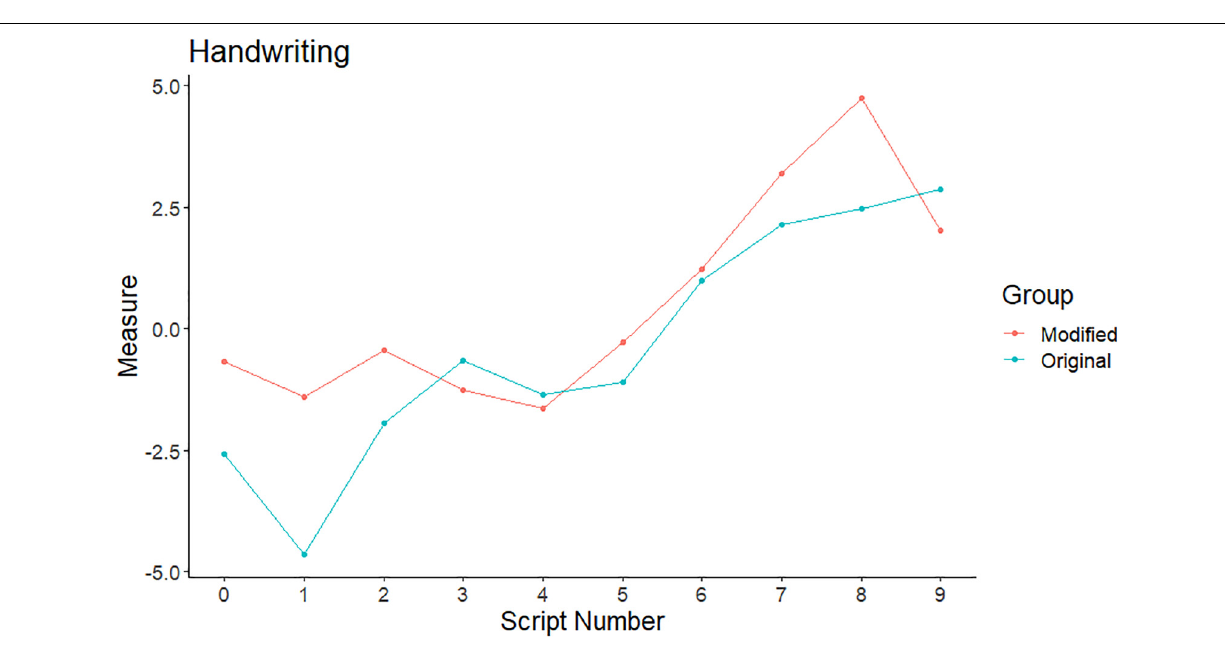
FIGURE 3 | CJ measures for the original and modified script variants: